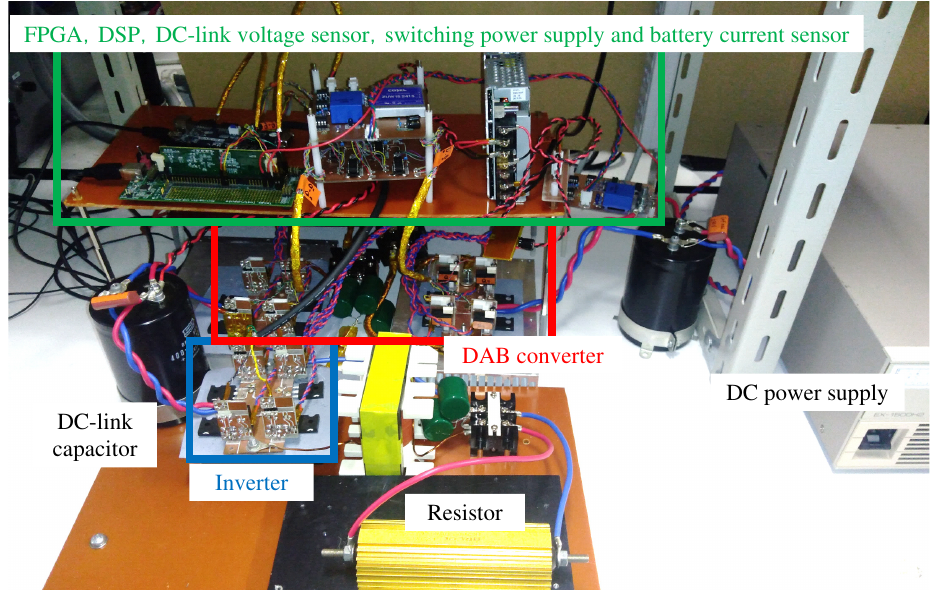
Figure 13. Experimental setup of DAB converter-based WPGS in battery-discharging